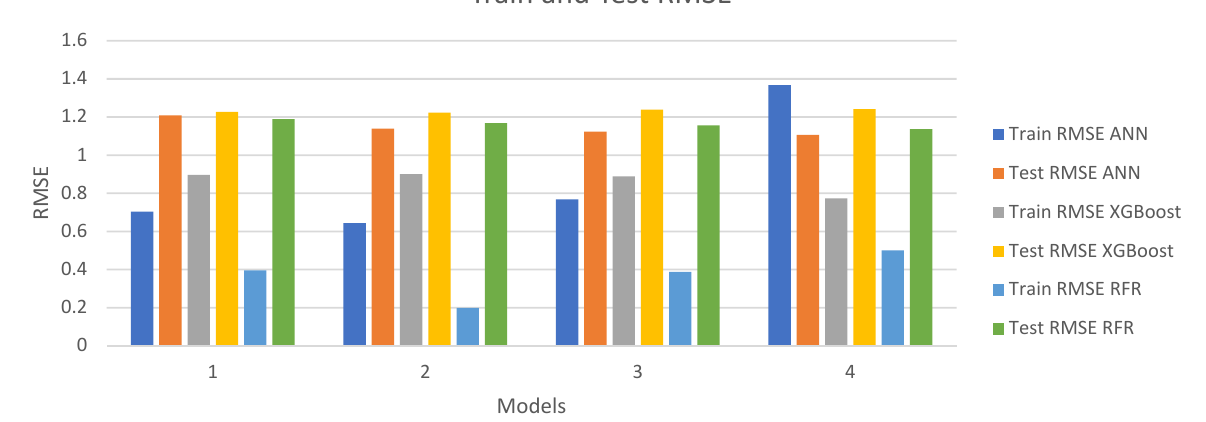
Figure 13. Train and test RMSE for all prediction methods.